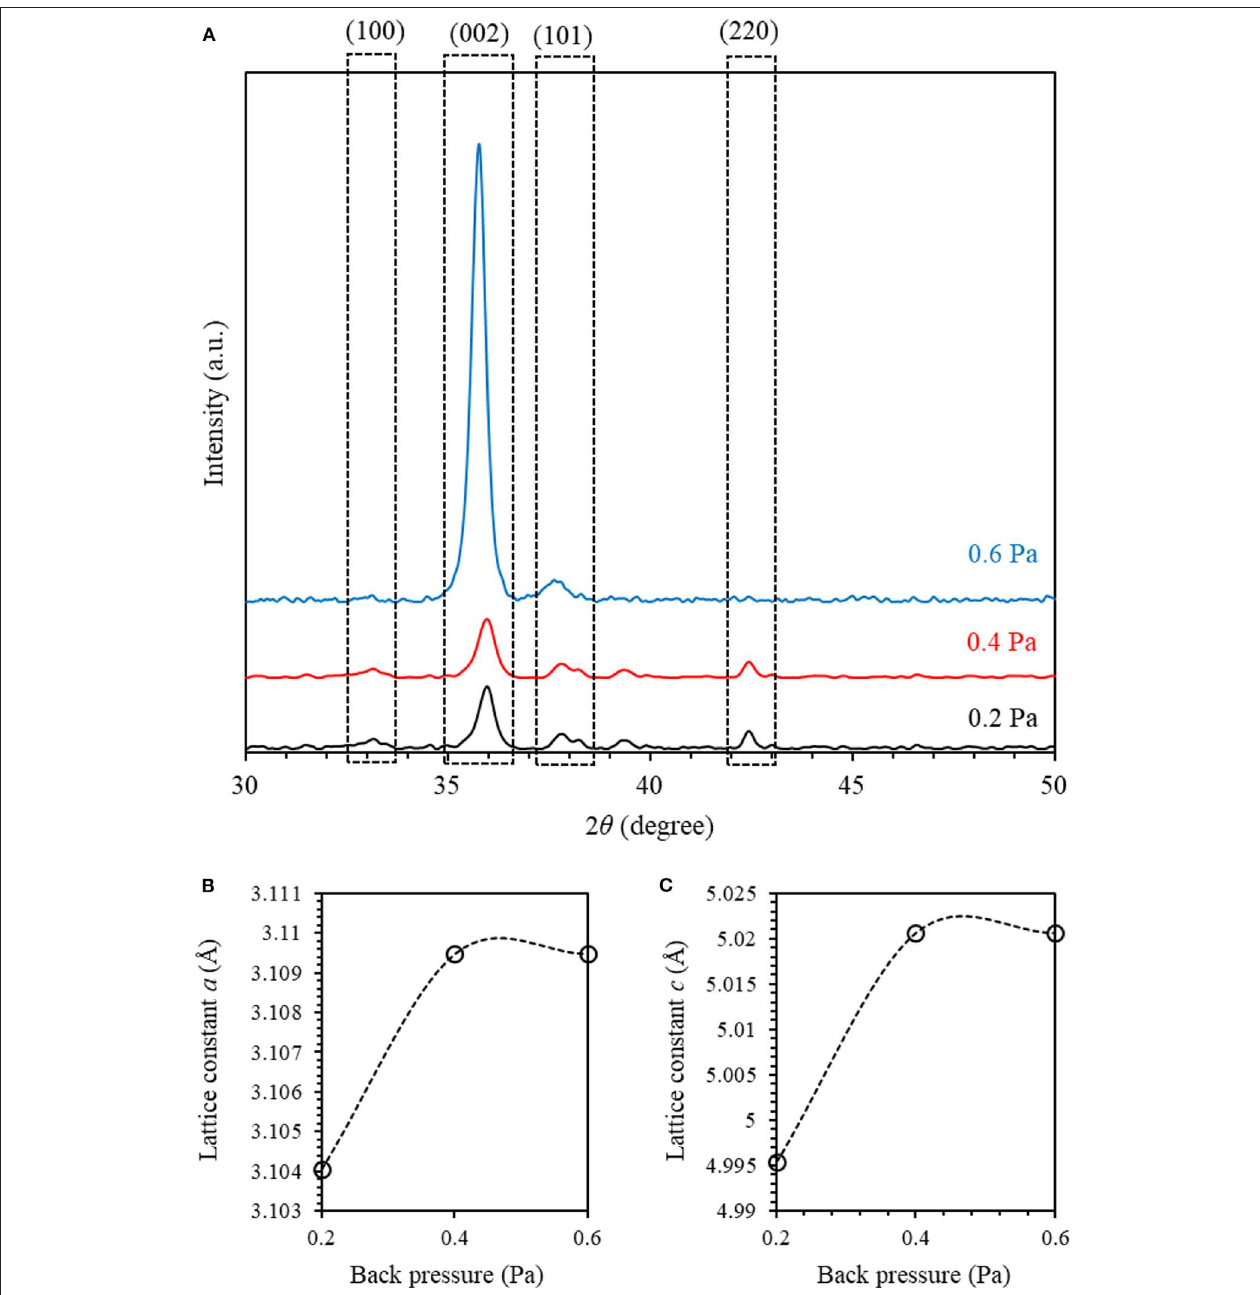
FIGURE 2 | (A) The X-ray diffraction (XRD) configurations of 550-nm thick aluminum nitride (AlN) thin films sputtered on a silicon substrate at a plasma power of 300W and with different back pressures with 100% N 2 atmosphere. (B,C) The in-plane and out-plane lattice constants ( a ) and ( c ) obtained from XRD patterns of sputtered AlN thin films as a function of back pressure,